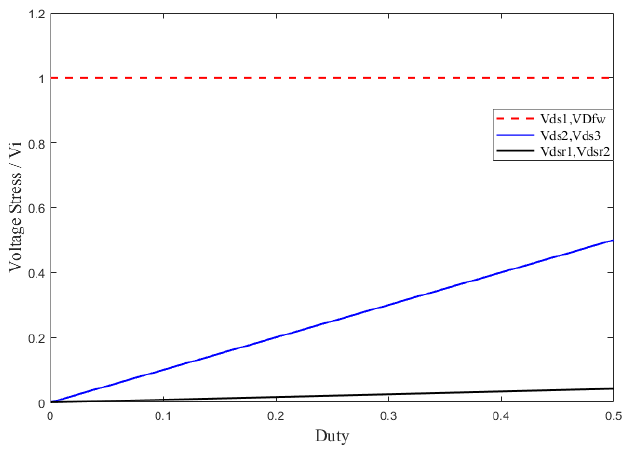
Figure 12. The estimated voltage stresses of switches.